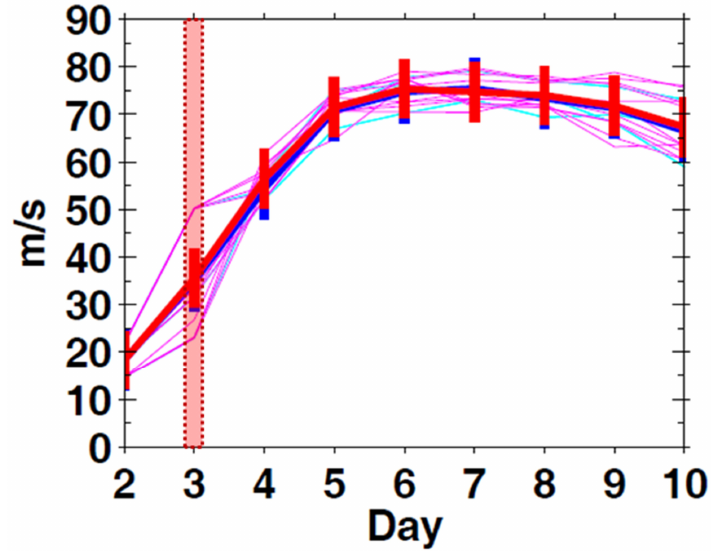
Figure 3. Maximum 10-m wind speed vs. model day from day 2 to day 10. Thick lines are ensemble means for control (blue) and eddy (red) experiments, with bars the 95% ± confidence intervals. Thin lines are individual members. The red dotted shade indicates when the warm eddy is under the typhoon core (~100 km) in the eddy experiment.